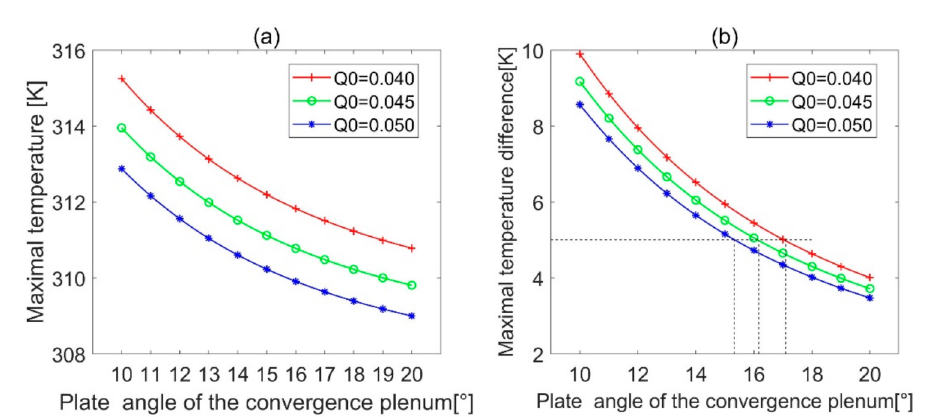
Figure 9. The effect of plate angle of the convergence plenum on the temperature distribution for various inlet airflow rates: ( a ) effect on maximal temperature, ( b ) effect on maximal temperature difference. ( θ dp = 15 ◦ , d 0 = 1 mm, w dp = 5 mm, w cp = 5